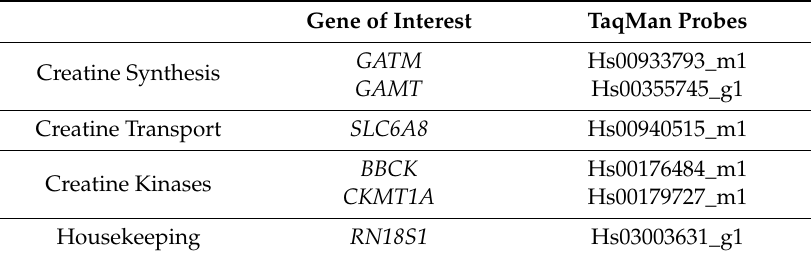
Table 2. TaqMan probe